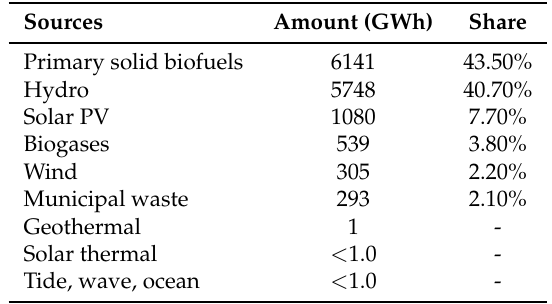
Table 1. Current status of electricity production from renewable energy facilities in Thailand [5].